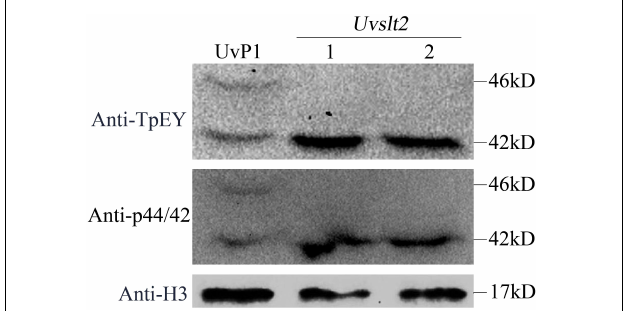
FIGURE 6 | Assays for the phosphorylation of UvPmk1 and UvSlt2 MAP kinases. Western blots of total proteins isolated from the wild-type strain P1 and Uvslt2 mutant were detected with an anti-TpEY phosphorylation specific antibody and an anti- p44/42 antibody. Phosphorylation and expression of UvSlt2 was detected in the wild-type but not in the Uvslt2 mutant. Detection with an anti-H3 antibody (Cell Signaling Technology) was to show that similar amount of proteins were loaded for each